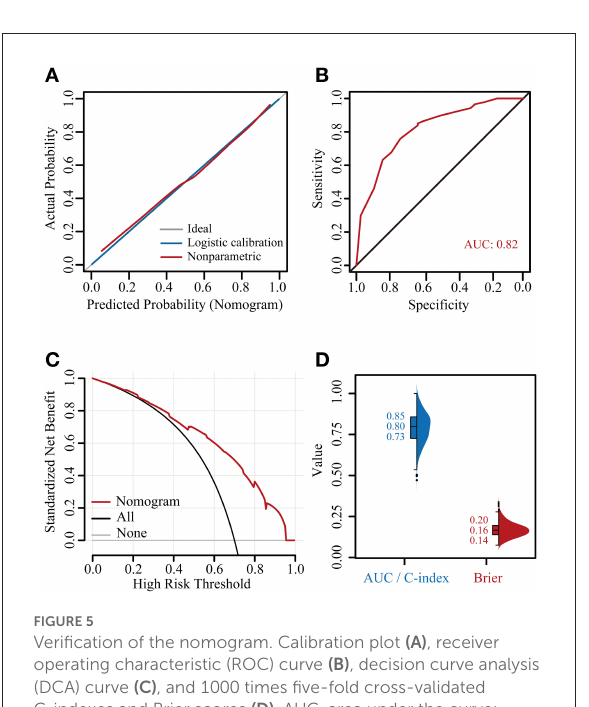
FIGURE5 Verification of the nomogram. Calibration plot (A) , receiver operating characteristic (ROC) curve (B) , decision curve analysis (DCA) curve (C) , and 1000 times five-fold cross-validated C-indexes and Brier scores (D) . AUC, area under the curve; C-index, concordance index.